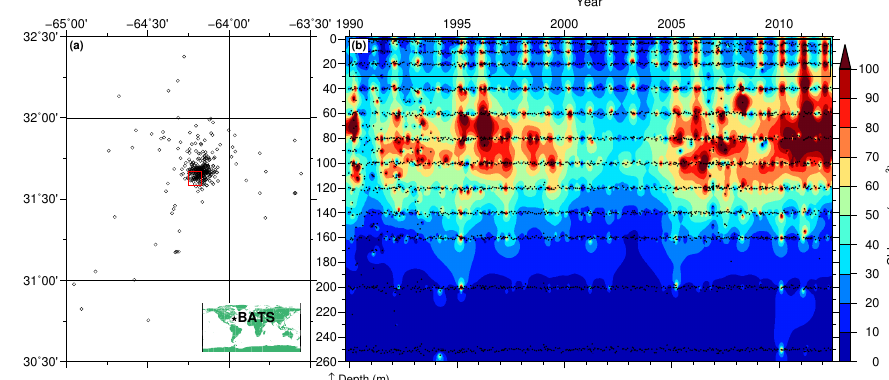
Figure 1. Horizontal (a) and vertical (b) distribution of pigment measurements taken at BATS (black dots) overlaid on a contour plot of HPLC-measured Chl a hapto at BATS. The red box in (a) shows the PIC grid cell containing the most BATS measurements (PIC data shown in Fig. 8), while the black box in (b) shows the upper 30m of measurements used for PIC-Chl a hapto correlations and correlations presented in Fig.